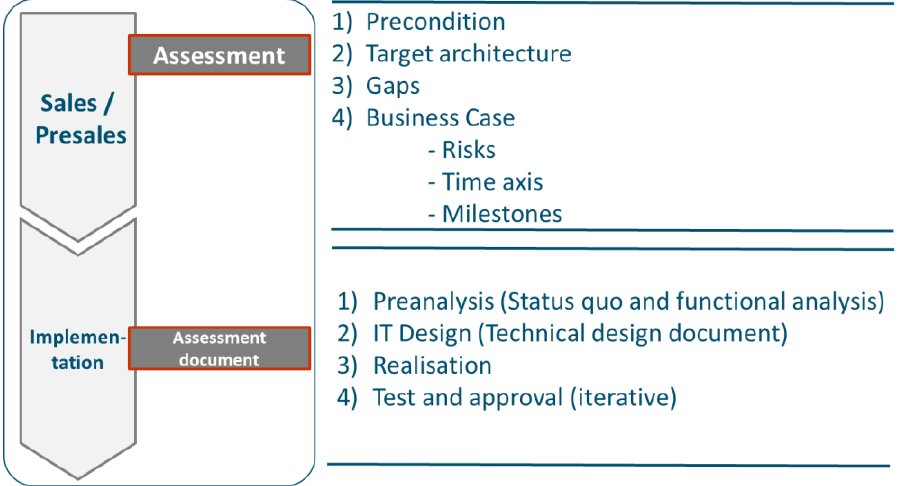
Figure 5. The different implementation